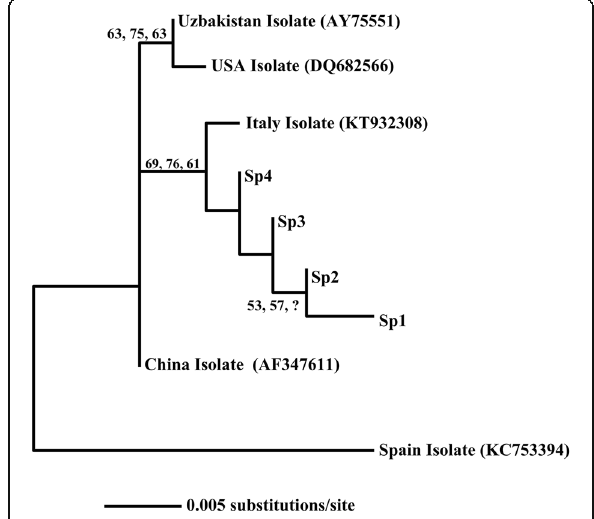
Fig. 2 ML tree constructed from 477 bp of ITS-I, 5.8 gene, ITS-II sequenced in this study. The values at some nodes refer to the bootstrapping of maximum-parsimony, neighbor-joining and maximum-likelihood, respectively which were shown when they were over 50%. The numbers between brackets are the accession numbers of the sequences collected from the GenBank database